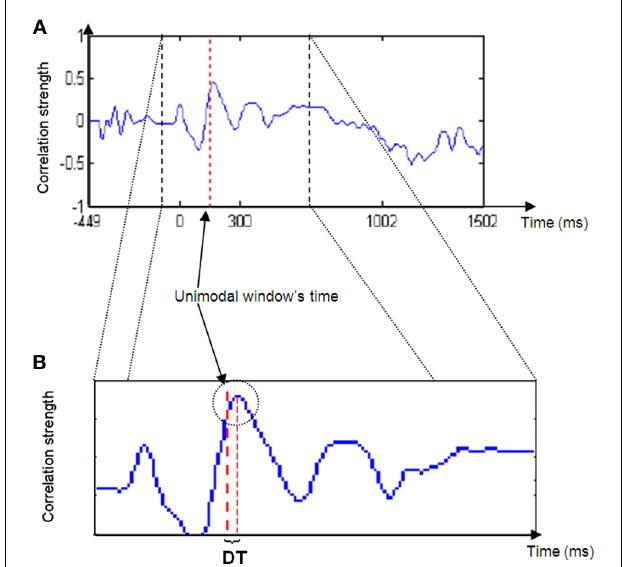
FIGURE 2 | Cross-correlation strength graph. Note the peak in graph strength in the area of the unimodal time window (right red dashed line in B ) and the delta time (DT) between the line and the peak